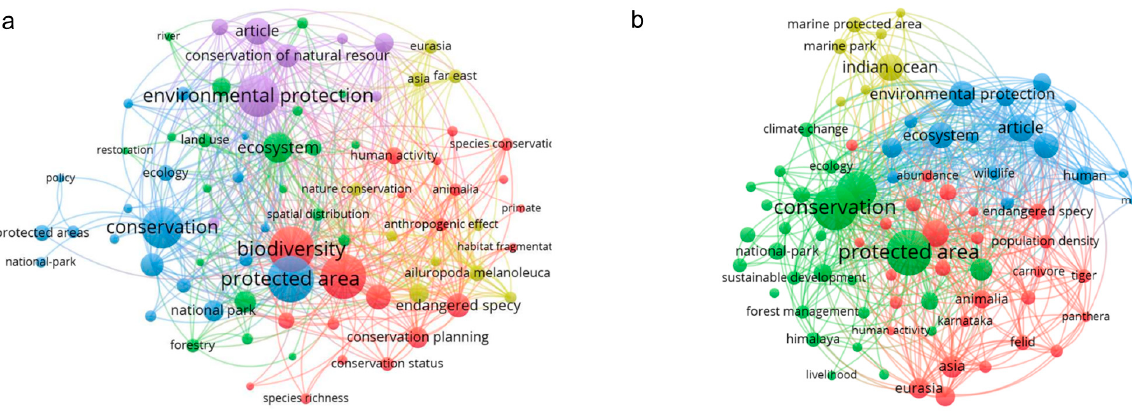
Figure 5. Keyword co-occurrence network of CPAP studies ( a ) and IPAP studies ( b ). The node size represents the frequency of occurrence, and each color represents a category.